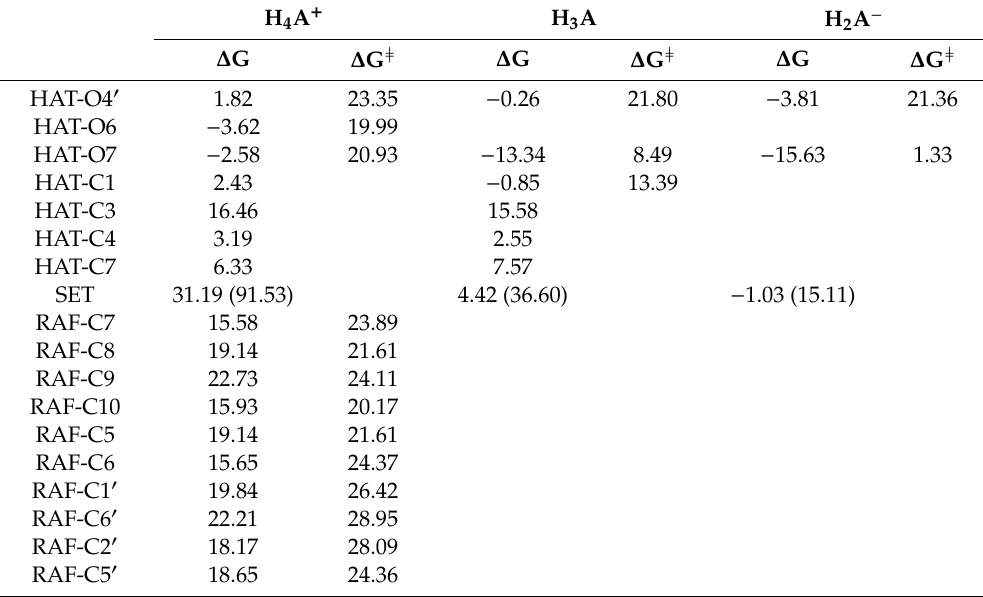
Scheme 1. Schematic representation of the considered mechanisms for higenamine and its acid–base forms. Gibbs free energies of reaction ( Δ G) and activation ( Δ G ⧧ ), for all populated species in aqueous and pentylethanoate (PE) solvents, involved in the studied mechanisms are summarized in Table 2. HAT, hydrogen atom transfer, RAF, radical adduct formation, SET, single-electron transfer. Table 2. Gibbs free energies of reaction ( Δ G) and activation ( Δ G ⧧ ), expressed in kcal mol − 1 , at 298.15 K. in aqueous solution involved in HAT and SET. The Δ G values calculated in PE medium are reported in parenthesis.